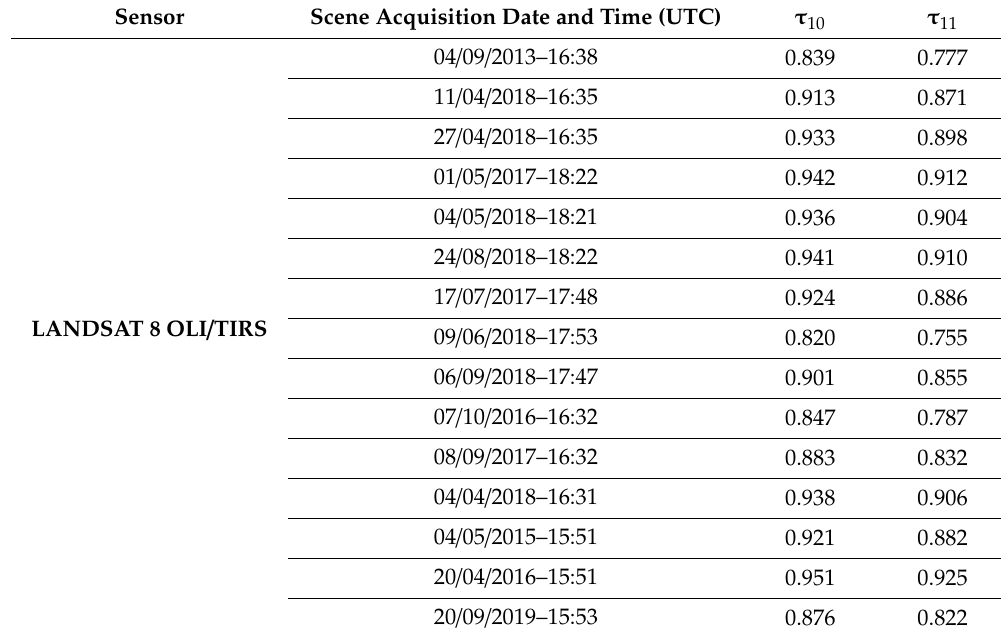
Table A7. Atmospheric transmittance values for Band 10 and Band 11 of Landsat 8 TIRS data used in